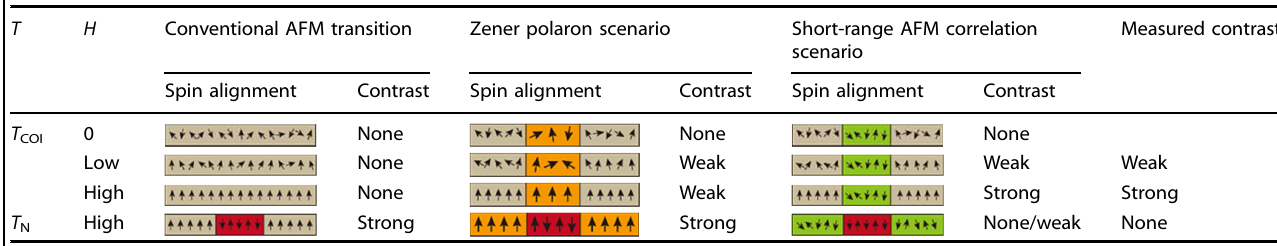
Table 1. Qualitative comparison between different scenarios and measured MFM contrast.